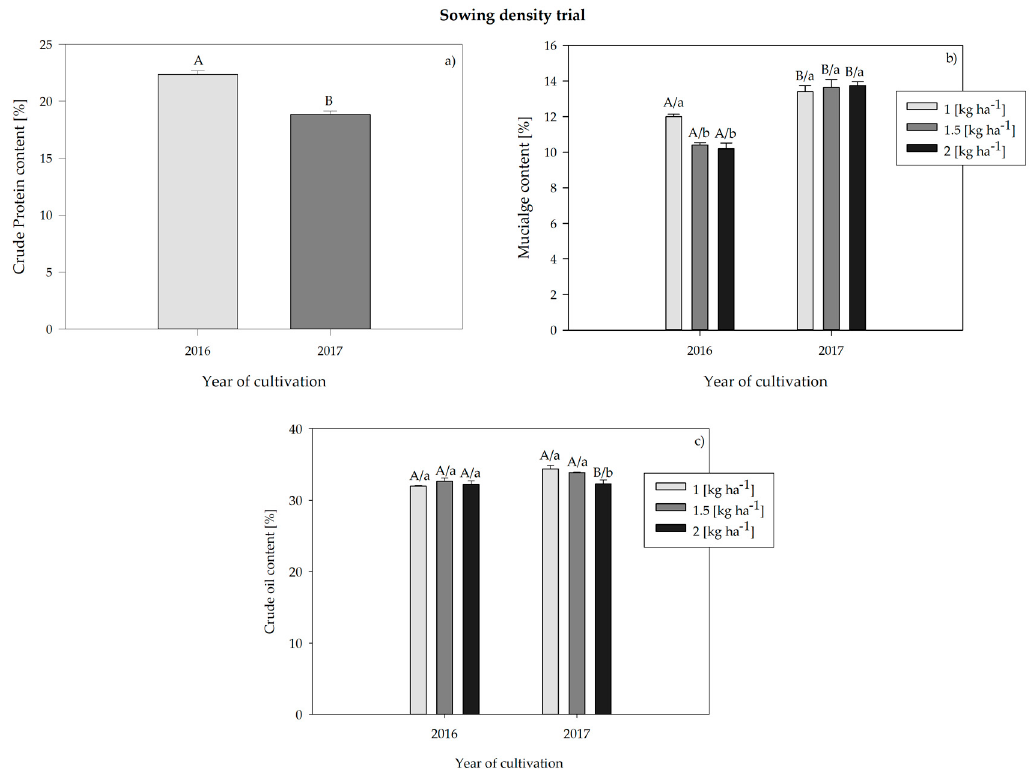
Figure 3. Mean estimates of crude protein ( a ), mucilage ( b ) and crude oil ( c ) content of the genotype G8 cultivated in 2016 and 2017 at Ihinger Hof at different sowing densities. Means at a constant level of sowing density that share a common capital letter do not differ significantly between years at α = 0.05. Means within a year that share a common lowercase letter do not differ significantly between sowing densities at α = 0.05 (estimates, standard errors, and Tukey HSD test are based on model (2); for F -test results compare Table S1).